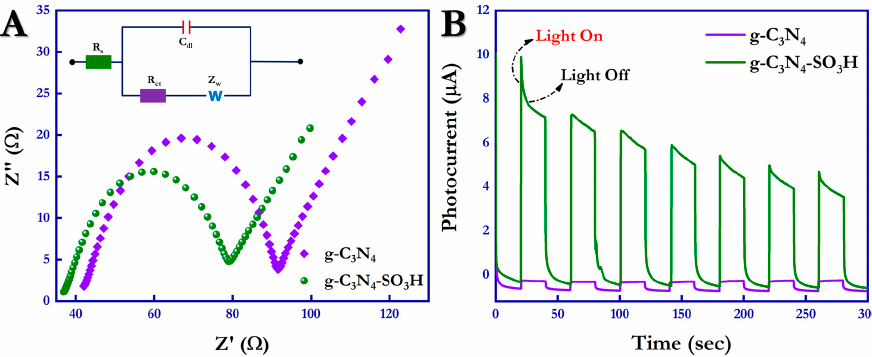
Figure 14. Electrochemical impedance spectroscopy (EIS) ( A ) and transient photocurrent response (TPC) ( B ) of as-synthesized g-C 3 N 4 and g-C 3 N 4 -SO 3 H. Furthermore, the transient-photocurrent (TPC) measurements were performed in NaOH electrolyte solution with the applied potential of − 0.1 V in the presence (On) and absence (Off) of visible light irradiation, displayed in Figure 14B. The obtained data showed that the photocurrent response exerted by the surface-functionalized g-C 3 N 4 – SO 3 H (9.8824 µA) was almost ~4000 times the current response of pure g-C 3 N 4 (2.4629 nA) under irradiation. Notably, the sulfur effect exercised by the functionalized photocatalytic material on charge separation and carrier density was the reason for the enhanced photo- current response. This photocurrent response shows the boosted mobility and lifetime of the charge carriers and thus the photocatalytic activity.